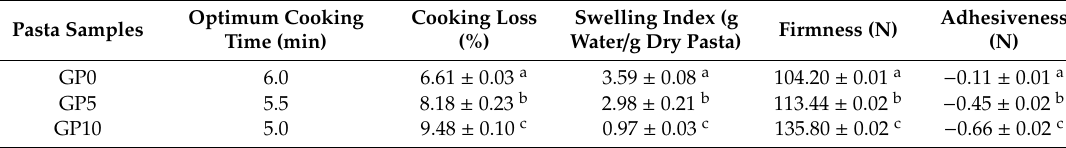
Table 1. Cooking quality parameters and texture analysis of control pasta (GP0) and pasta fortified with di ff erent percentages of grape pomace (GP5 and GP10). The values are reported as mean ± standard deviation.